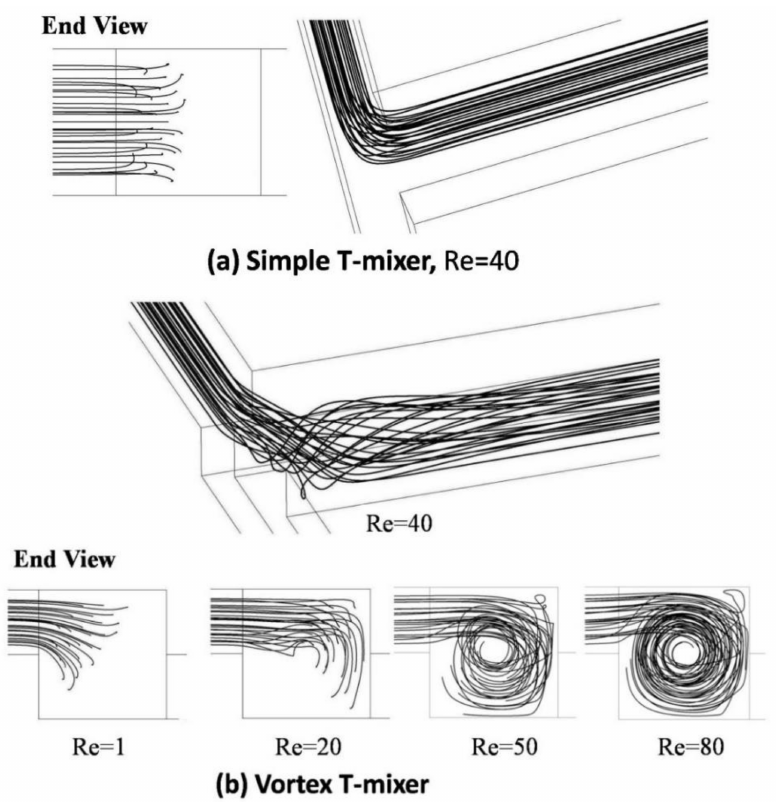
Figure 4. Projected streamlines shown in end view and three-dimensional view: ( a ) simple micro T-mixer and ( b ) vortex micro T-mixer.